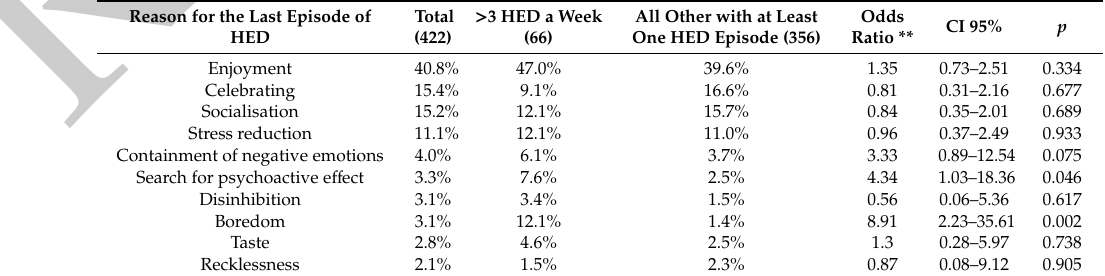
Table 3. Reason for the last episode of HED: profile of subjects with “more than three HED a week” versus all others with at least one HED episode